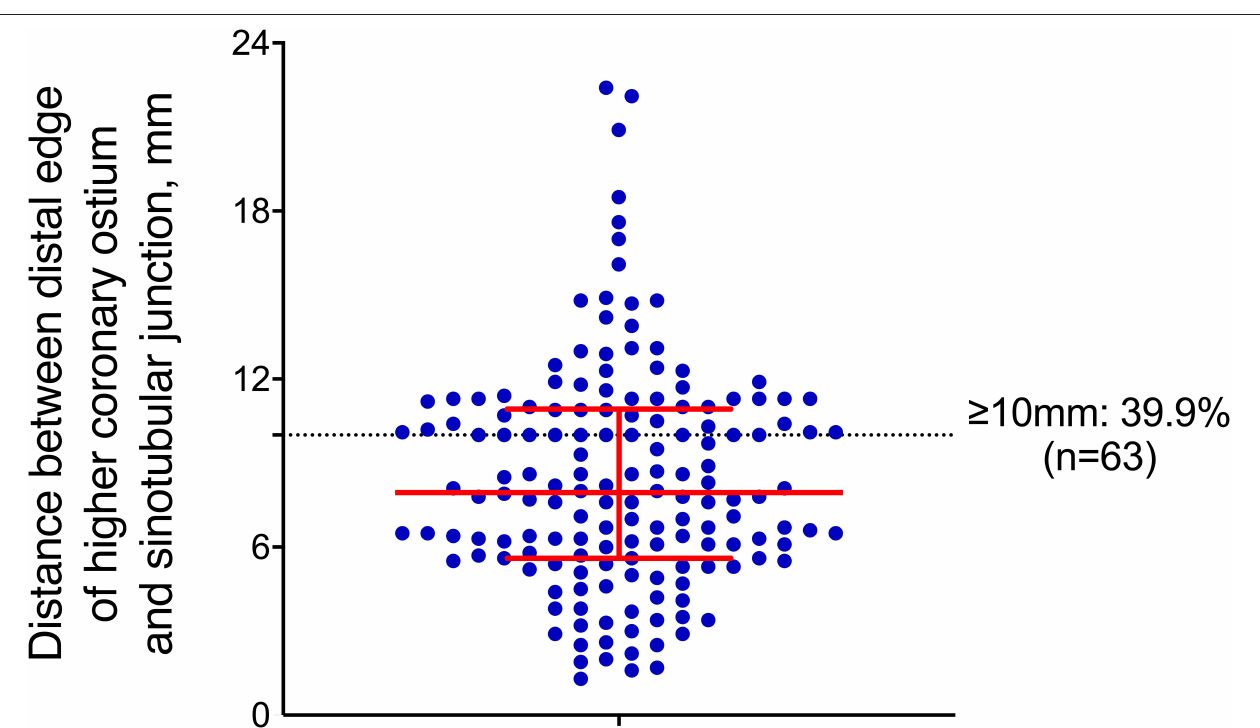
FIGURE 3 | Distance between the distal edge of the higher coronary ostium and STJ, where the red bar indicates the median, 1st-3rd interquartile ranges, and each blue dot represents a single